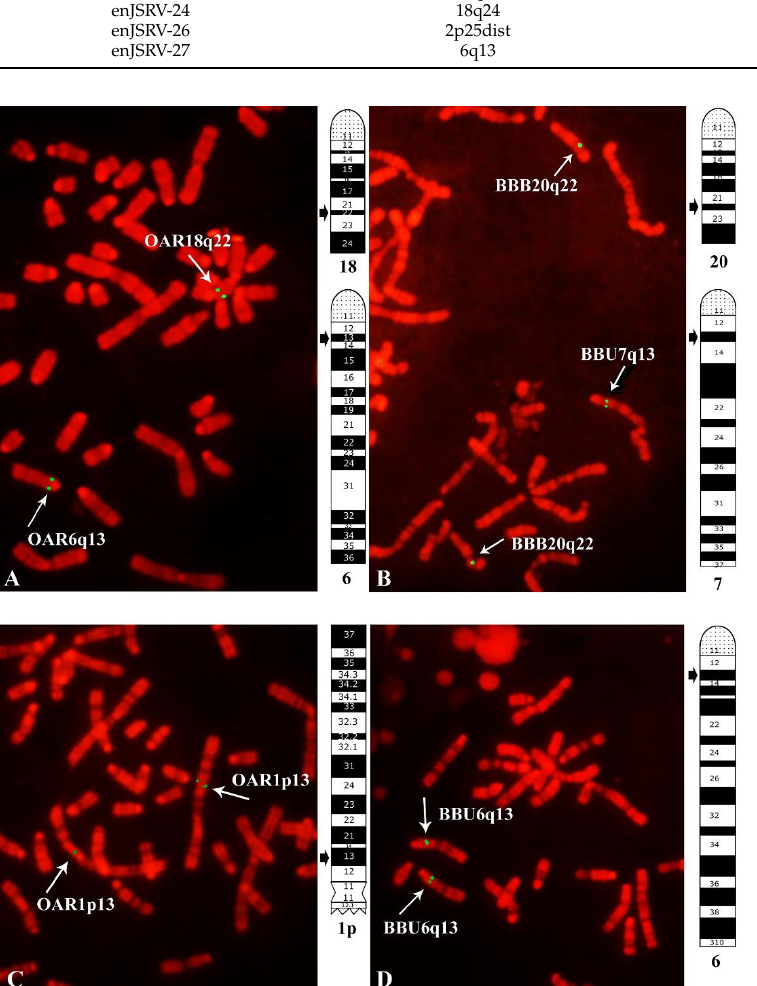
Figure 1. FISH mapping of enJSRV-1 ( A , B ) and enJSRV-10 ( C , D ) in sheep (OAR) and river buffalo (BBU) chromosomes. Two different images were taken, with hybridization FITC signal and with RBPI-banding. Subsequently, hybridization FITC signals were superimposed on RBPI-banding to get a precise localization of mapped loci in both species. Note that enJSRV-1 maps onto two different chromosomes in both species ( A , B ).